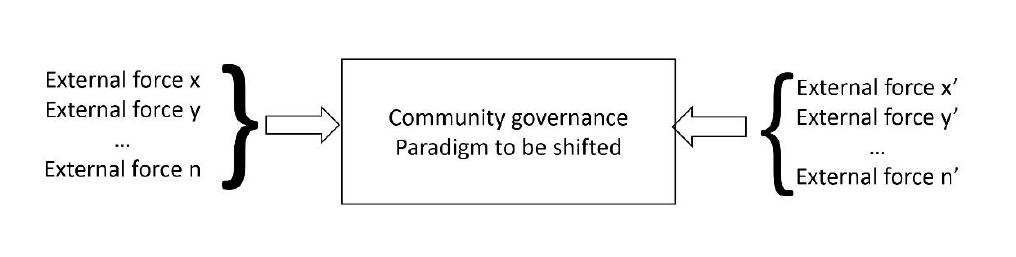
Fig. 8. Social physics framework of analysis into the community governance shift (developed by the